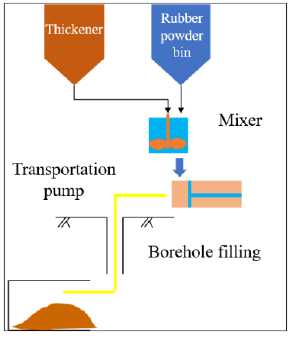
Figure 18. Filling